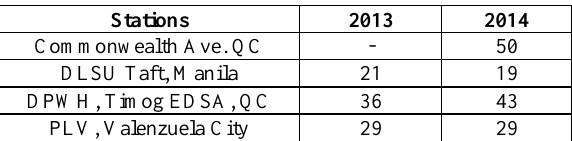
Table 1. PM 2.5 annual levels in NCR monitoring stations (Source: NAQSR, 2015)